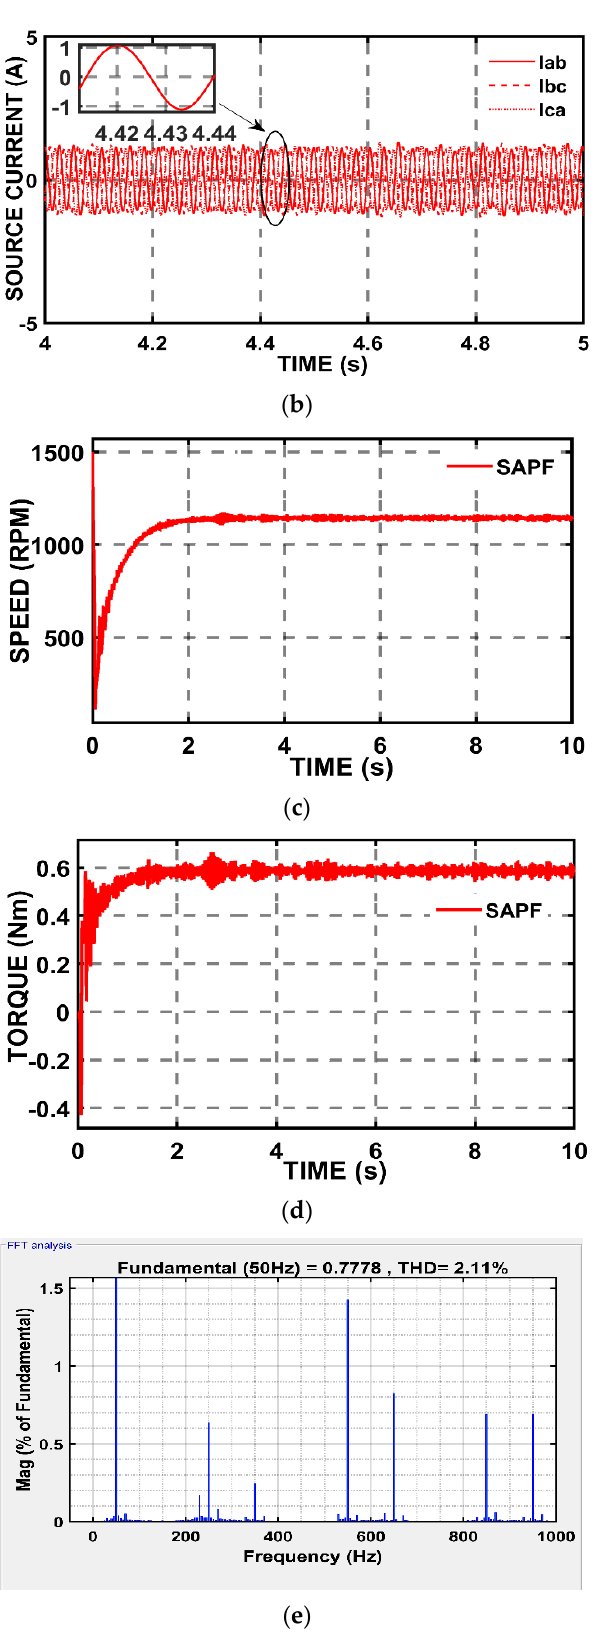
Figure 9. The performance of the drive using an active filter for case 1. ( a ) Source voltage. ( b ) Source current. ( c ) Speed. ( d ) Torque. ( e ) THD of source current.